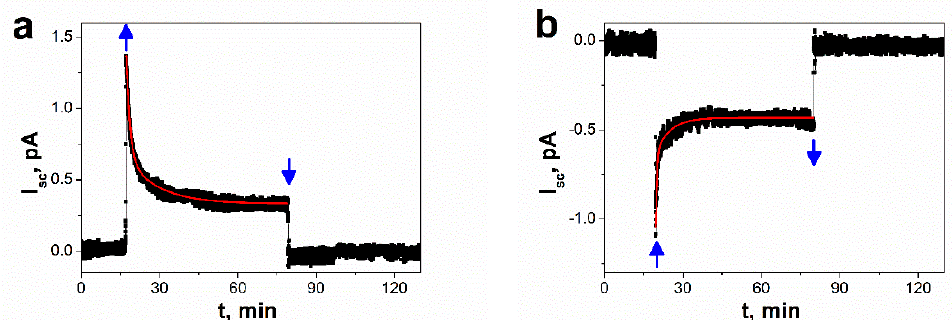
Figure 6. Time dependences of short-circuit photovoltaic current responses on switching on ( ↑ ) and switching off ( ↓ ) illumination of the SbSI FE-PV device with different poling electric fields: ( a ) E = − 10 6 V/m, ( b ) E = +10 6 V/m ( λ = 488 nm; P opt = 127 mW/cm 2 ; U = 0 V; T = 268 K; p = 2 × 10 − 3 Pa; red solid curves represent the best fitted dependences described by Equation (4); values of the fitted parameters are presented in Table 3). Table 3. Parameters of Equation (4) fitted to short-circuit photocurrent responses of SbSI nanowires to switching on illumination, as shown in Figure 6.